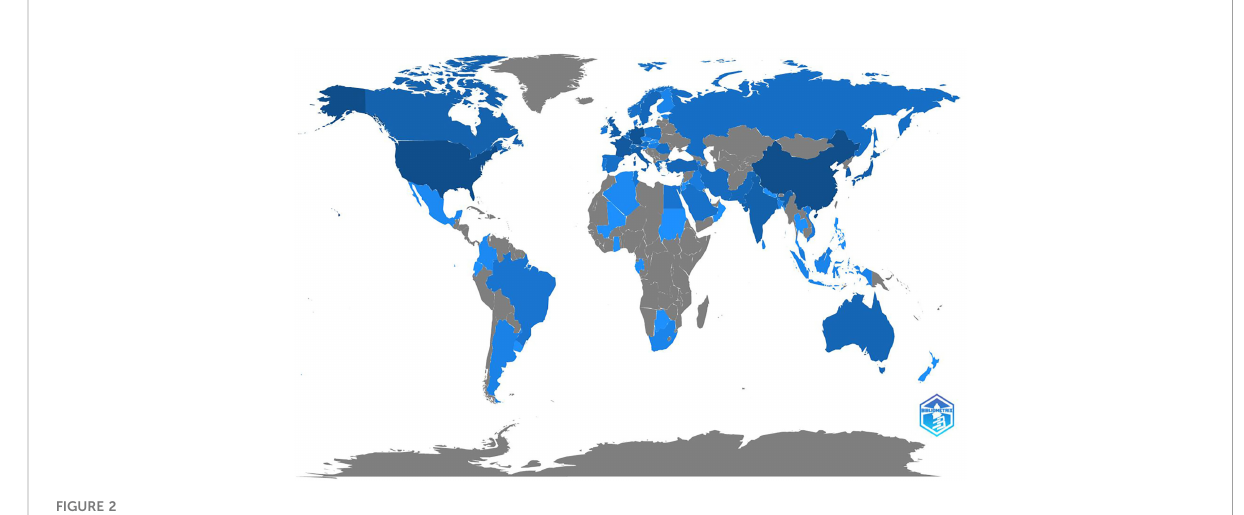
“ Cancers ” with a number of publications of 64, 52, and 43, respectively.